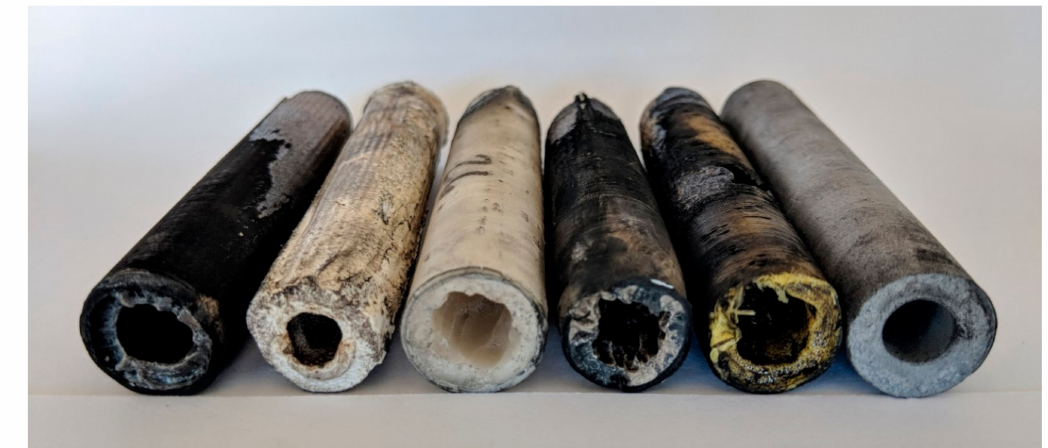
Figure 4. Combustion port comparisons, left to right: ABS, PLA, PP, ASA, PTEG, and